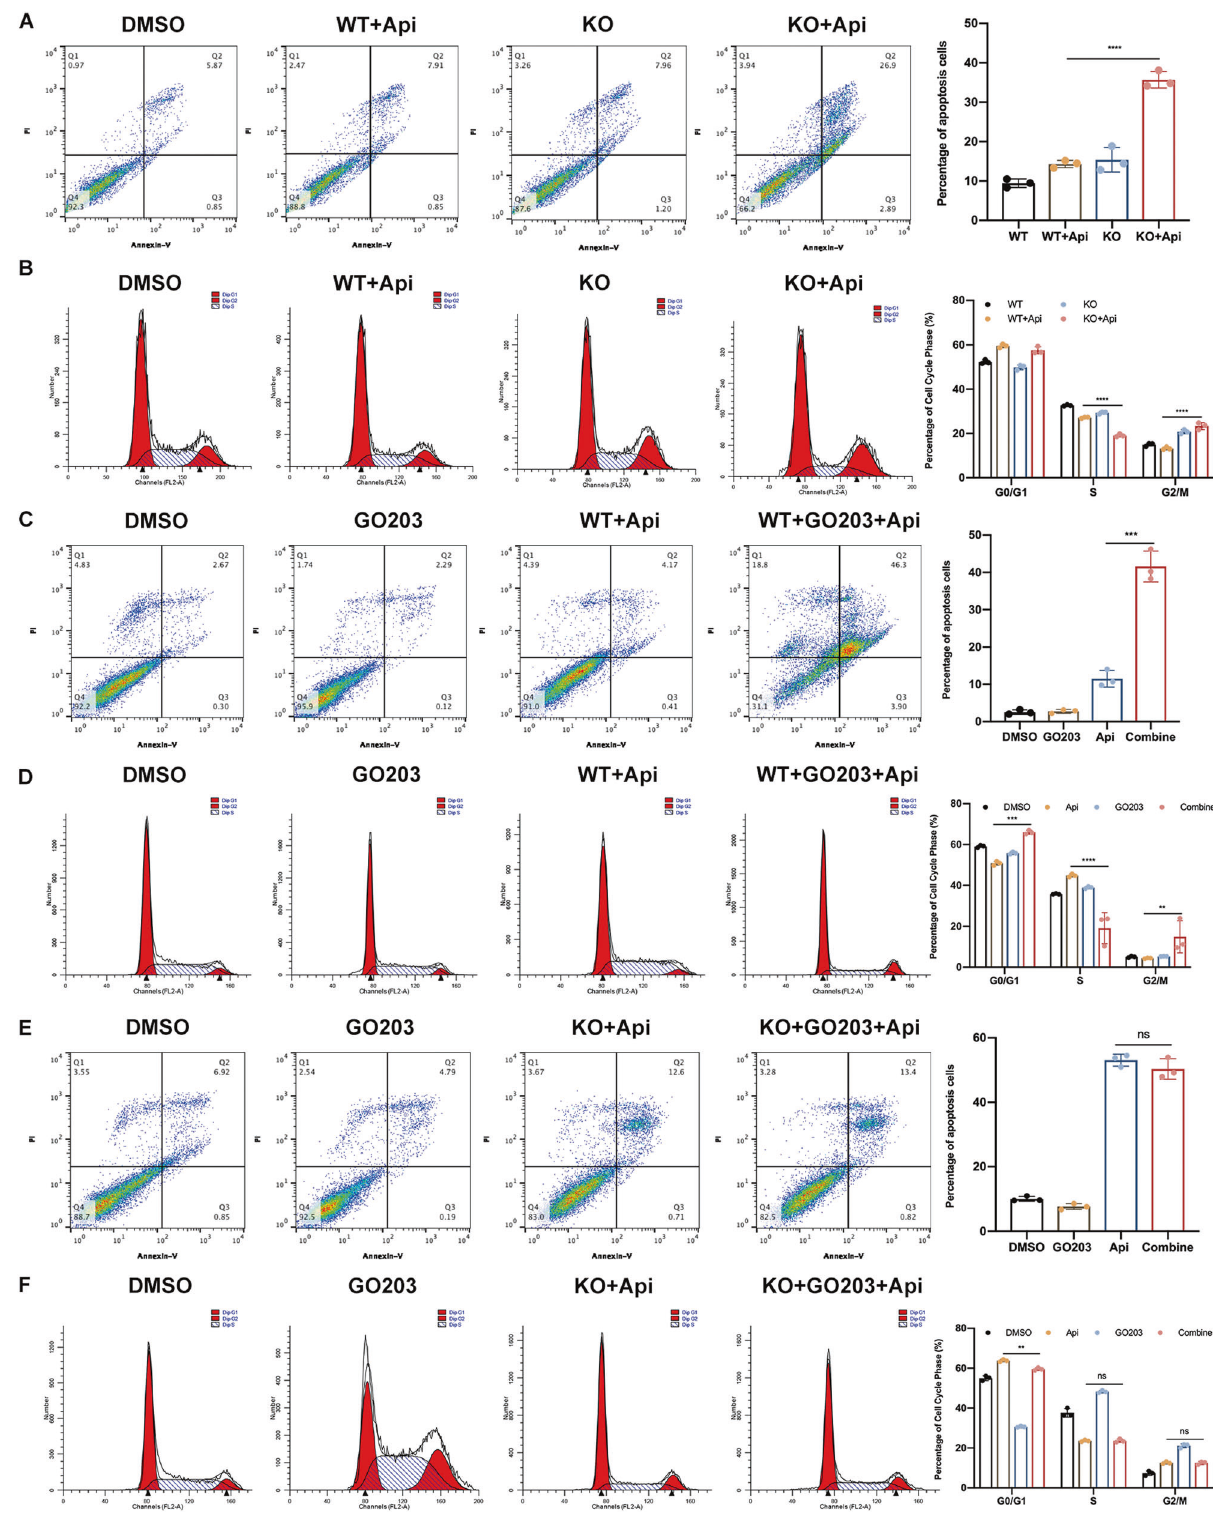
Fig. 2 Targeting MUC1 enhanced the apoptosis and cell cycle arrest in MCF-7 cells. A Apoptotic fl ow cytometry of WT/KO cells treated with 50 μ M apigenin for 48 h. B Cell cycle fl ow cytometry of WT/KO MCF-7 cells treated with 50 μ M apigenin for 48 h. C Apoptotic fl ow cytometry of WT MCF-7 cells treated with GO 203 and apigenin for 48 h. D Cell cycle fl ow cytometry of WT MCF-7 treated with GO203 and apigenin for 48 h. E Apoptotic fl ow cytometry of KO MCF-7 cells treated with GO 203 and apigenin for 48 h. F Cell cycle fl ow cytometry of KO MCF-7 treated with GO203 and apigenin for 48 h. Each group was analyzed in triplicate. * P < 0.05; ** P < 0.01; *** P < 0.001 for comparisons.